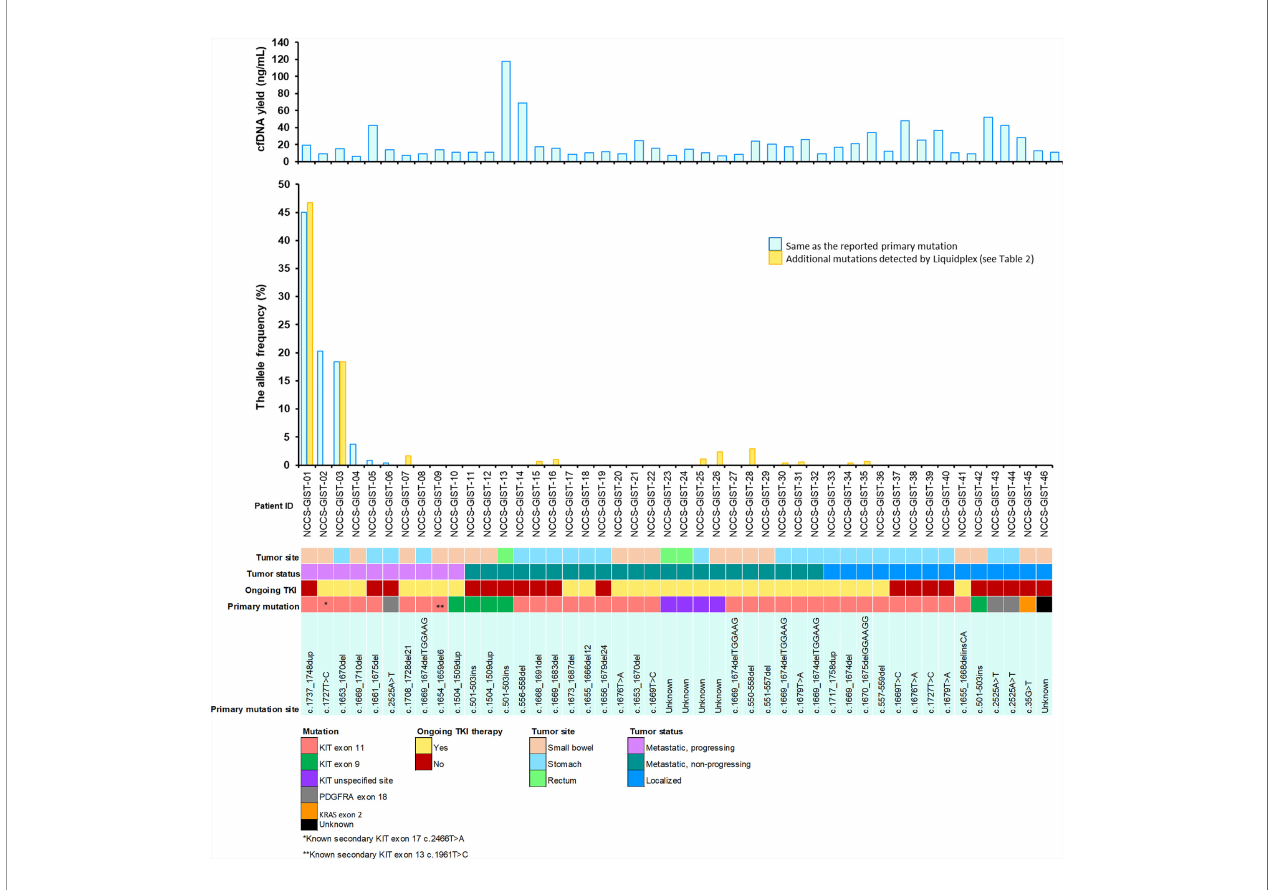
FIGURE 1 | Overview of study cohort and plasma ctDNA mutation detection. Clinical and molecular characteristics of the 46 patients included in the study are shown. For the mutant allele frequency bar chart, the light blue bar indicates mutants that were detected in ctDNA are the same as that reported for the corresponding primary tumor. The gold-colored bar indicates additional mutants detected in ctDNA that is not reported in the corresponding primary tumor. See Table 2 for more information on the mutation pro fi les of both the primary tumor and the corresponding